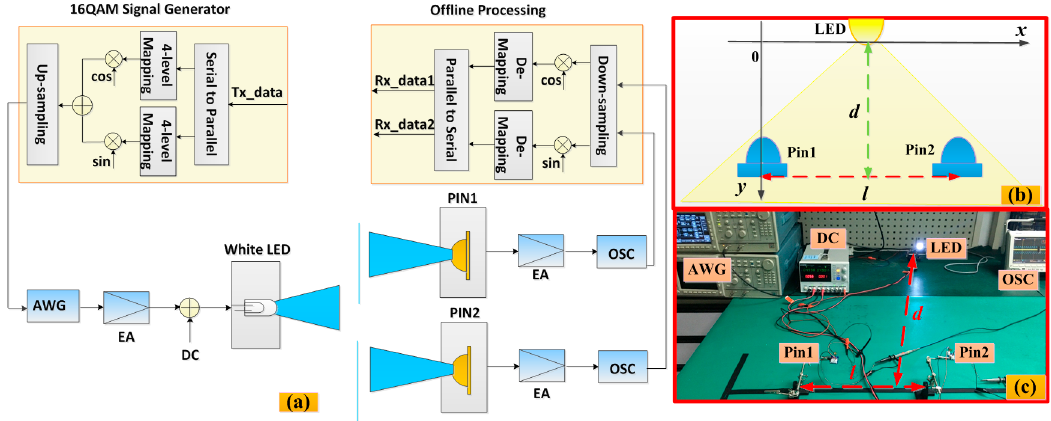
Figure 2. ( a ) The block diagram of the proposed VLC positioning range-testing system. EA: electrical amplifier, DC: direct current, OSC: real-time oscilloscope; ( b ) The schematic of experimental setup; ( c ) The experimental setup of measuring positioning range.